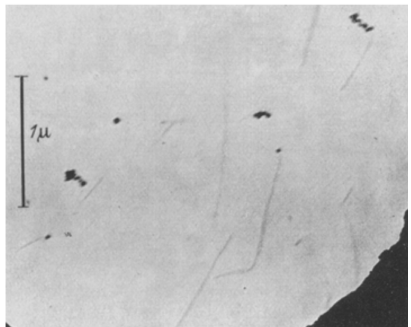
Figure 7. Images of the tobacco mosaic virus obtained by Gustav Kausche, Edgar Pfankuch, and Helmut Ruska in 1939, using an electron microscope. Reprinted from [22] by permission from Springer Nature, copyright